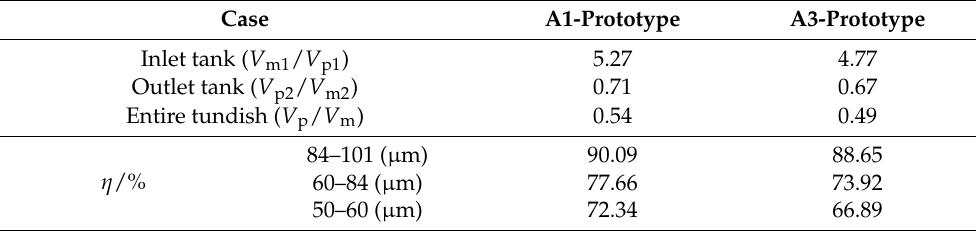
Table 10. Ratio between mixed flow volume and plug flow volume and inclusion removal rate (CFD